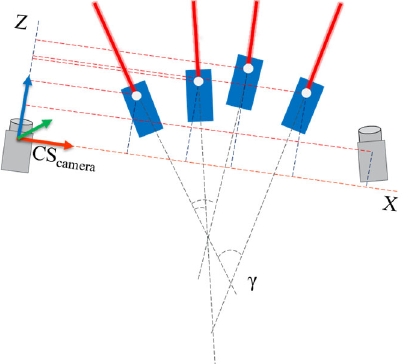
Figure 9. Relative orientation of the fan-shaped distance